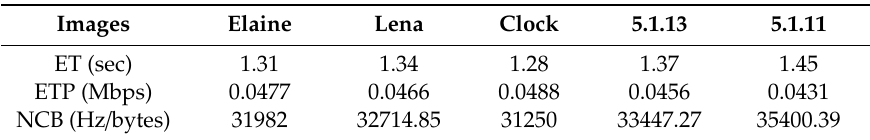
Table 7. ET, ETP, and NCB of sample